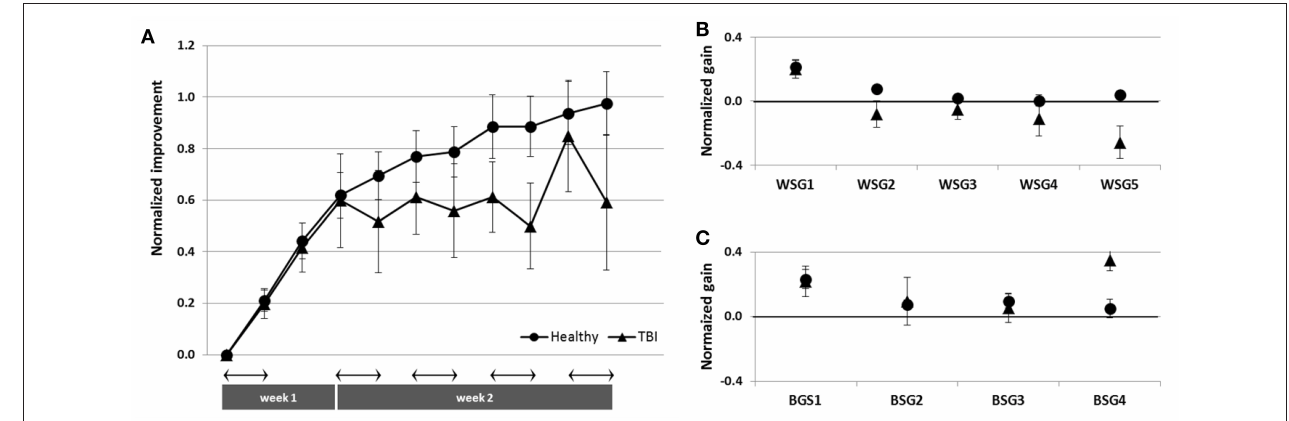
FIGURE 6 | Normalized data for the Trained TBI (triangles) and the Trained Healthy (circles) groups. (A) Time-course of improvement across multi-session training. (B) Normalized within-session gains (WSGs) and (C) normalized between-session gains (BSGs).